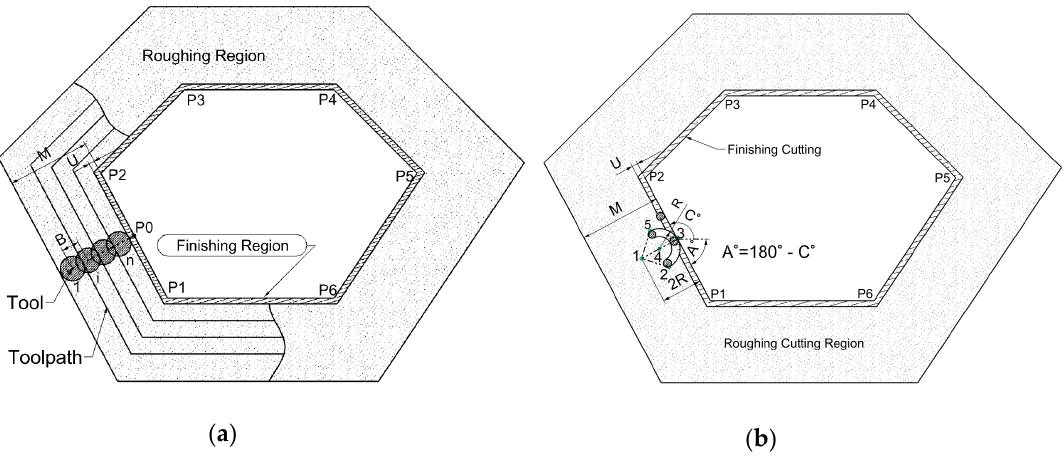
Figure 5 . Toolpaths for ( a ) rough, and ( b ) finish machining. Figure 5. Toolpaths for ( a ) rough, and ( b ) finish